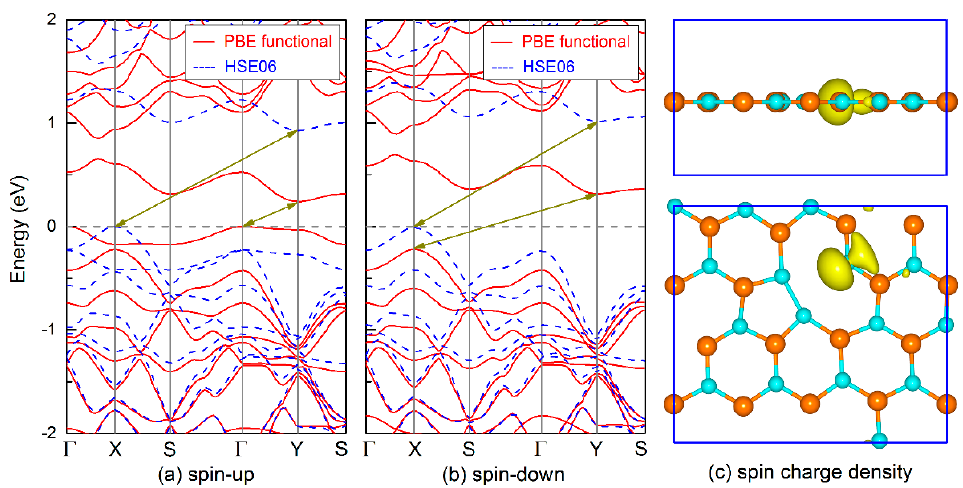
Figure 5. Electronic band structures for ( a ) spin-up and ( b ) spin-down channels, and ( c ) spin-charge density of the P_v defective monolayer. The isosurface of charge density is set to 0.02 e ·Å − 3 .